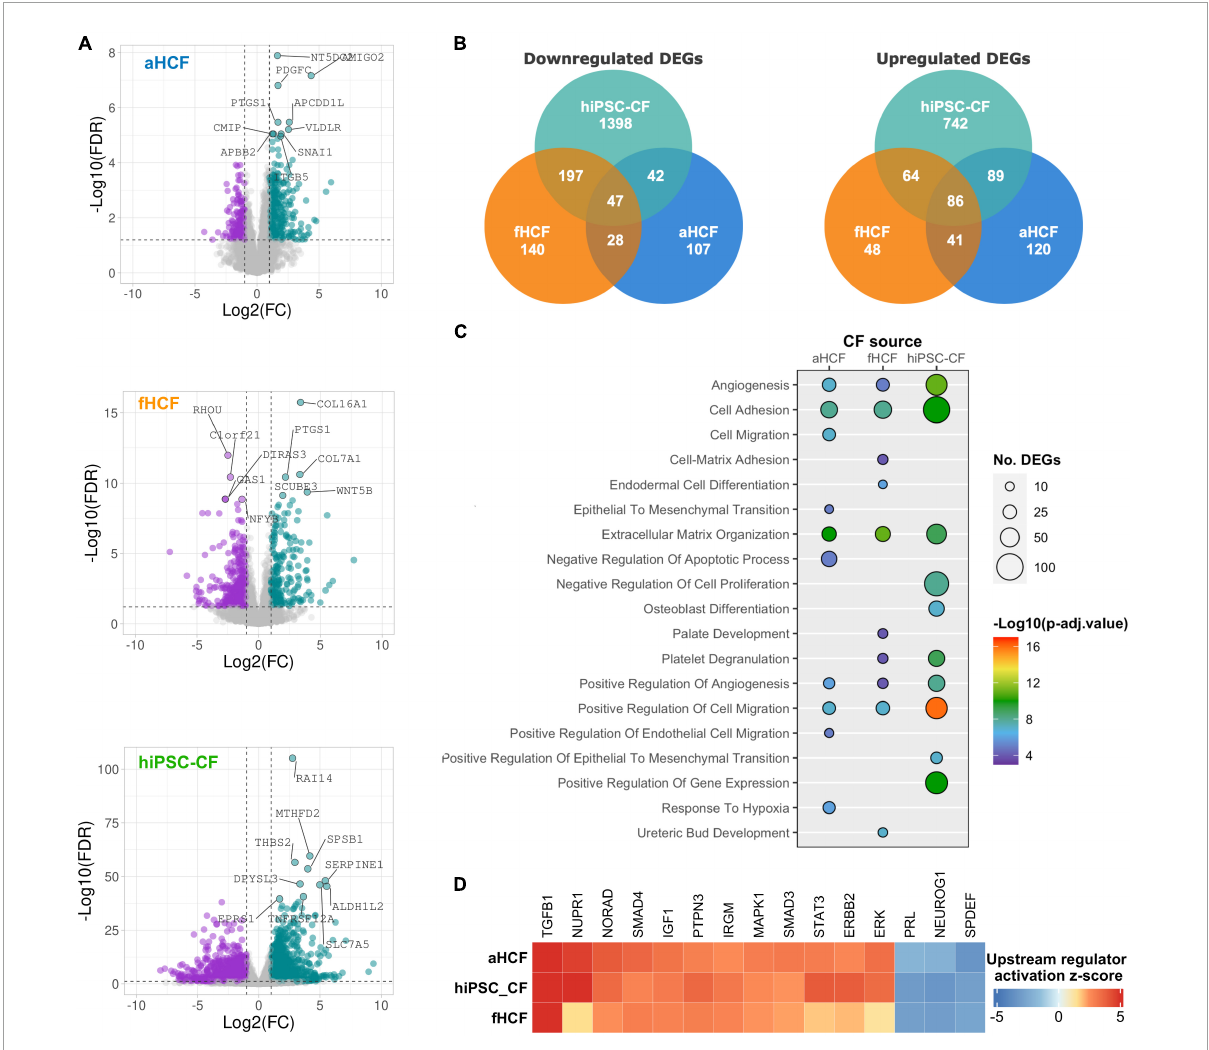
FIGURE3 Transcriptional changes upon CF activation reveal a convergent remodeling in different CF sources (A) Volcano plots of differentially expressed genes between control and TGF- β -treated conditions, for each CF source. Downregulated genes are in purple and upregulated genes in green, non-significant changes are in gray. The top 10 modulated genes are annotated. Applied thresholds for fold-change: − 1 and 1; significance: 1.2. (B) Venn diagrams showing the comparison of upregulated DEGs and downregulated DEGs between the CF sources. (C) Bubble plot shows the top 10 biological processes enriched for each CF source. Bubble size indicates the number of genes associated with each term and bubble color indicates the significance of the enrichment. (D) Heatmap from a comparative analysis of upstream regulators activation z-score of top 15 upstream regulators determined by ingenuity pathway